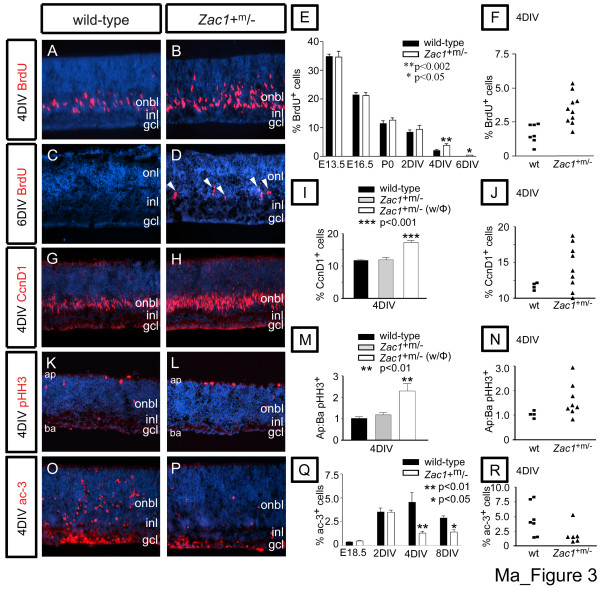
Loss of Zac1 results in increased proliferation and reduced apoptosis at a late stage of retinogenesis. (a-d) BrdU labeling (red) of E18.5 wild-type and Zac1+m/- explants cultured 4DIV (a,b) or 6DIV (c,d). Arrowheads in (d) mark ectopic proliferating cells. (e) Percentage of BrdU+ nuclei in wild-type (black bar; E13.5: 2,824 BrdU+/8,235 DAPI+; E16.5: 2,234 BrdU+/10,663 DAPI+; E18.5: 2,859 BrdU+/27,380 DAPI+; E18.5→2DIV: 4,371 BrdU+/54,554 DAPI+; E18.5→4DIV: 988 BrdU+/55,300 DAPI+; E18.5→6DIV: 0 in 9 fields) and Zac1+m/- retinae (grey bars; E13.5: 3,555 BrdU+/10,413 DAPI+; E16.5: 3,369 BrdU+/15,707 DAPI+; E18.5: 2,212 BrdU+/17,642 DAPI+; E18.5→2DIV: 3,298 BrdU+/35,085 DAPI+; E18.5→4DIV: 3,474 BrdU+/97,499 DAPI+; E18.5→6DIV: 54 BrdU+/11,618 DAPI+). (f) BrdU-labeling indices of individual wild-type (squares) and Zac1+m/- (triangles) E18.5→4DIV retinal explants. (g,h) E18.5→4DIV wild-type (g) and Zac1+m/- (h) retinal explants labeled with CcnD1 (red). (i) Percentage of Ccdn1+ cells in wild-type (black bar; 2,480 CcnD1+/21,329 DAPI+) and Zac1+m/- without aberrant proliferation (grey bar; 3,156 CcnD1+/26,328 DAPI+) and with a proliferative phenotype (w/φ; white bar; 3,266 CcnD1+/18,709 DAPI+) at 4DIV. (j) Ccnd1-labeling indices of individual wild-type (squares) and Zac1+m/- (triangles) E18.5→4DIV retinal explants. (k,l) E18.5→4DIV wild-type (k) and Zac1+m/- (l) retinal explants labeled with pHH3 (red). (m) Apical (Ap) to basal (Ba) ratio of pHH3+ cells in wild-type (black bar; 808 ap:791 ba pHH3+) and Zac1+m/- without (grey bar; 971 ap:796 ba pHH3+) and with (w/φ; white bar; 1,012 ap:480 ba pHH3+) a proliferative phenotype at 4DIV. (n) Ap:Ba ratios of pHH3+ cells in individual wild-type (squares) and Zac1+m/- (triangles) E18.5→4DIV retinal explants. (o-p) Active caspase-3 (Ac-3) expression (red) in wild-type and Zac1+m/- E18.5→4DIV explants. Blue is DAPI counterstain. (q) Percentage of apoptotic cells in the total population of wild-type (black bars; E18.5: 71 ac-3+/18,341 DAPI+; E18.5→2DIV: 532 ac-3+/14,995 DAPI+; E18.5→4DIV: 1,266 ac-3+/27,321 DAPI+; E18.5→8DIV: 294 ac-3+/10,209 DAPI+) and Zac1+m/- (white bars; E18.5: 67 ac-3+/13,768 DAPI+; E18.5→2DIV: 457 ac-3+/13,195 DAPI+; E18.5→4DIV: 488 ac-3+/24,077 DAPI+; E18.5→8DIV: 212 ac-3+/14,377 DAPI+) retinae. (r) Distribution of individual wild-type (squares) and Zac1+m/- (triangles) ac-3-labeling indices at 4DIV.